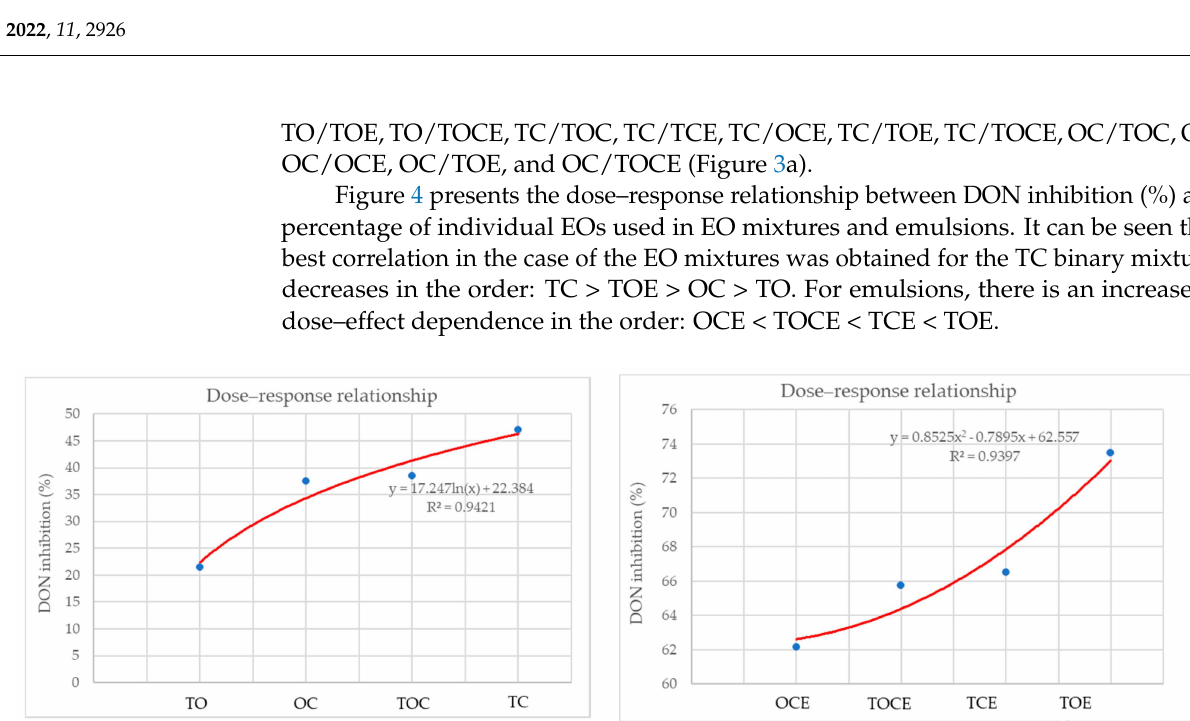
Figure 4. The dose–response relationship between DON inhibition (%) and the percentage of in- dividual EOs used in EO mixtures and emulsions. OC—binary mixture of oregano and coriander EOs; OCE—binary emulsion of oregano and coriander EOs; TO—binary mixture of thyme and oregano EOs; TOE—binary emulsion of thyme and oregano EOs; TC—binary mixture of thyme and coriander EOs; TCE—binary emulsion of thyme and coriander EOs; TOC—tertiary mixture of oregano, coriander, and thyme EOs; TOCE—tertiary emulsion of oregano, coriander, and thyme